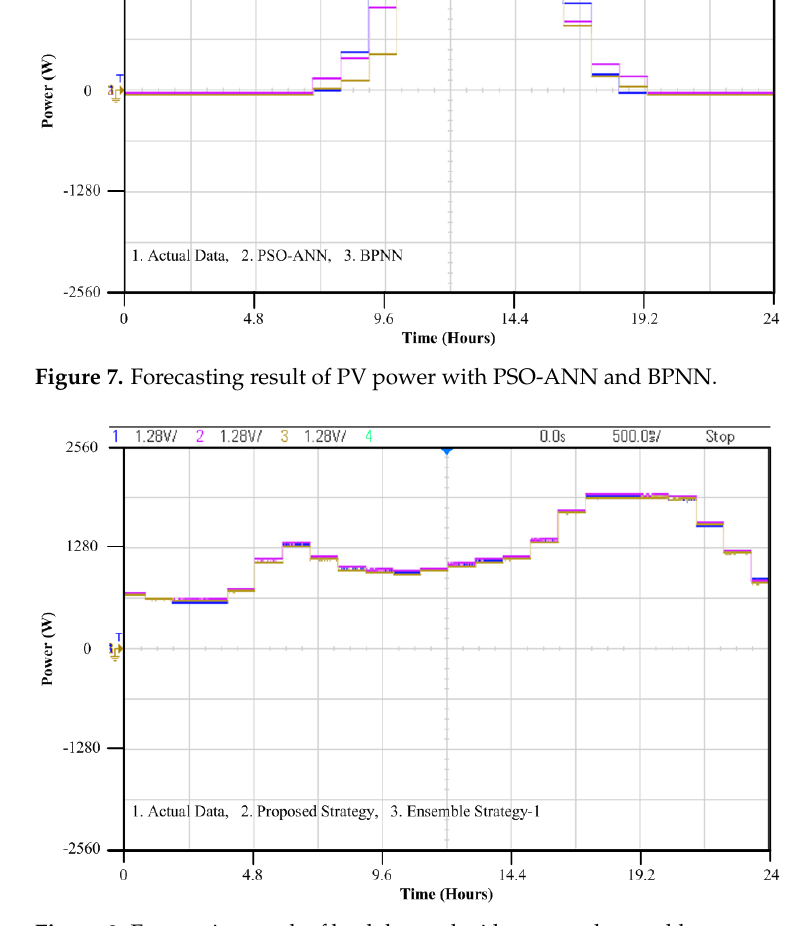
Figure 8. Forecasting result of load demand with proposed ensemble strategy and ensemble